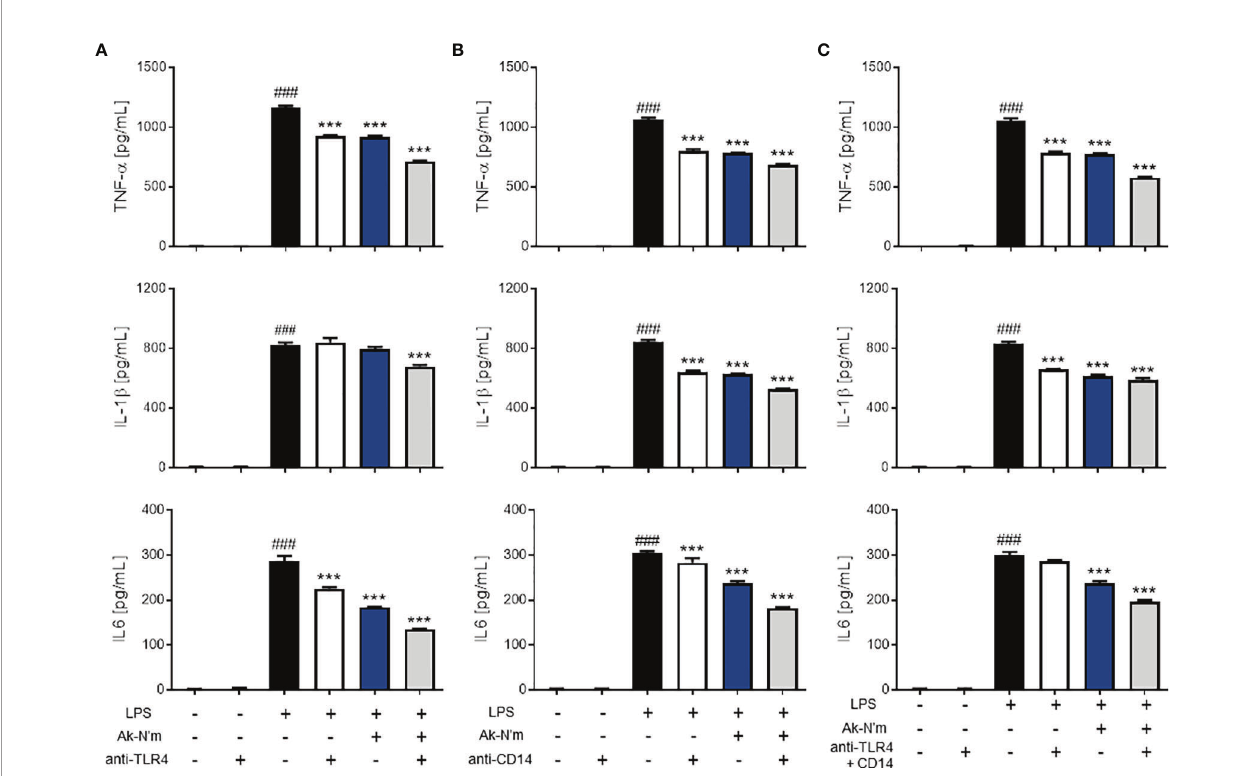
FIGURE 7 | Anti-in fl ammatory effects of Ak-N ’ m by interaction with TLR4 and CD14. To evaluate the interaction capability of the peptide with macrophage surface receptors, Ak-N ’ m (2 m M) was treated and compared with the functional inhibition of the receptors by their antibodies. (A) TLR4 blocking, (B) CD14 blocking, and (C) simultaneous blocking of TLR4 and CD14 was conducted via antibody treatment (5 m g/mL). The inhibition of cytokine secretion (TNF- a , IL-1 b , IL6) was compared among LPS-stimulated (black), antibody-treated (white), Ak-N ’ m-treated (blue) and antibody/Ak-N ’ m-co-treated (gray) groups. Treatment of Ak-N ’ m showed similar or stronger inhibitory effect on macrophage surface receptor than a single antibody treatment. ### p <0.001 compared difference between the negative and the positive group. Data are presented as mean ± SEM. ***p <0.001 indicates signi fi cant difference against LPS-stimulation with antibody and/or Ak-N ’ m